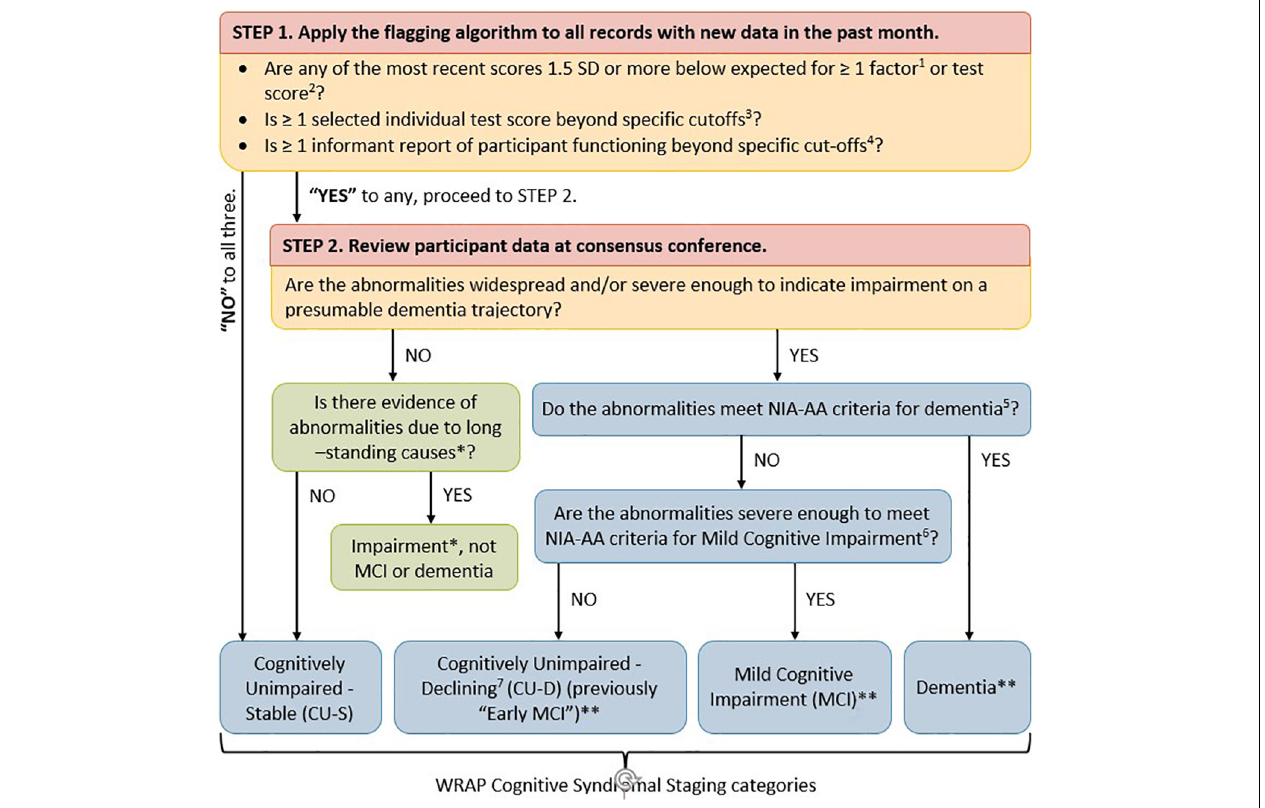
FIGURE 1 | Flow chart of WRAP approach to determining cognitive syndromal staging. Two-tiered review process for determining cognitive status at any given visit. (1) Koscik et al. (2014) describes robust internal norms for factor scores. (2) Clark et al. (2016) describes robust internal norms for individual neuropsychological test scores and how they were combined within theoretical domains. (3) Individual test score cut-offs include: Clock Draw Test ≤ 7; MMSE ≤ 26; AVLT Delayed Recall ≤ 5; and Logical Memory Delayed Recall ≤ 16. (4) Informant report cut-offs include CDR ≥ 0.5; QDRS ≥ 0.5; Lawton IADL < 14; and IQ Code > 52. (5) Jack et al. (2018) [Tables 3, 6 definition of dementia (McKhann et al., 2011)]. (6) Jack et al. (2018) [Tables 3, 6 definition of MCI (Albert et al., 2011)]. (7) As described in Jack et al. (2018; Table 3, and Stage 2 of Table 6). ∗ Impairment due to something other than probable developing dementia such as long-standing impairment associated with a learning disability or neurological disorder such as epilepsy. ∗∗ Probable/possible, primary/contributing etiologies assigned. CU-D group was referred to in previous WRAP publications as psychometric MCI and early